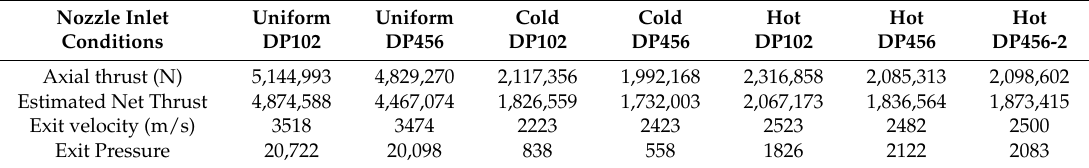
Figure 23. Pressure variation along the scramjet for different flow types. Table 11. Performance comparison of different nozzle inlet conditions at 10,000 ft. and Mach 8.